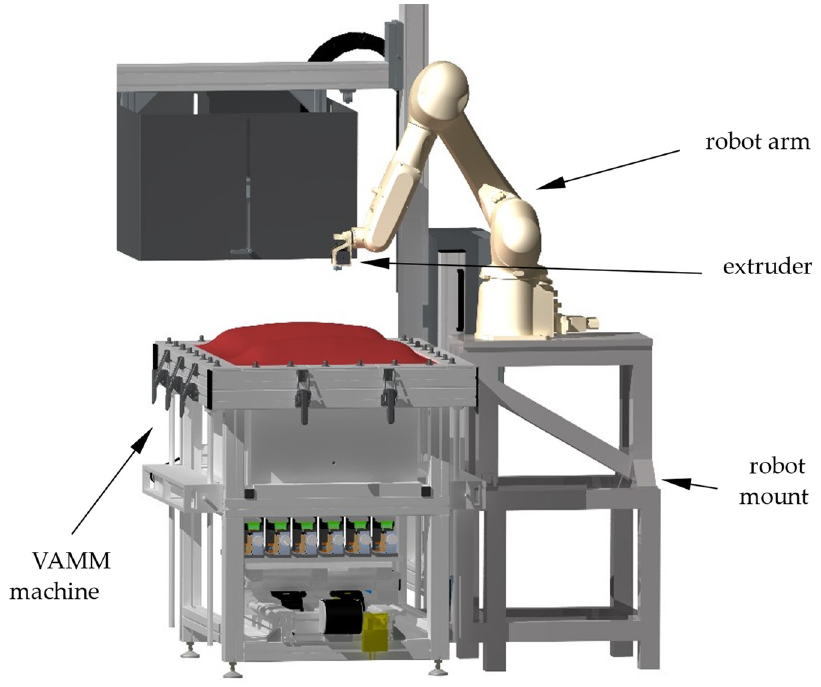
Figure 2. Rendering of the EMMA test rig.